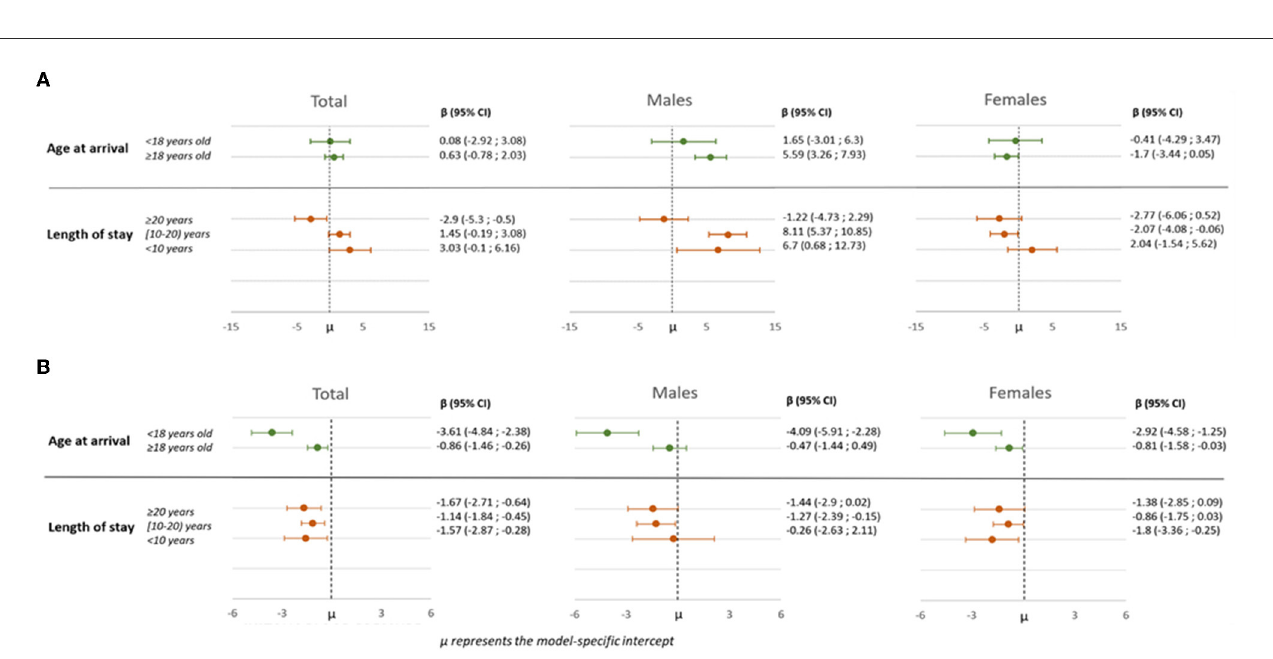
and stratified by sex. The results confirmed the findings observed for blood pressure levels.